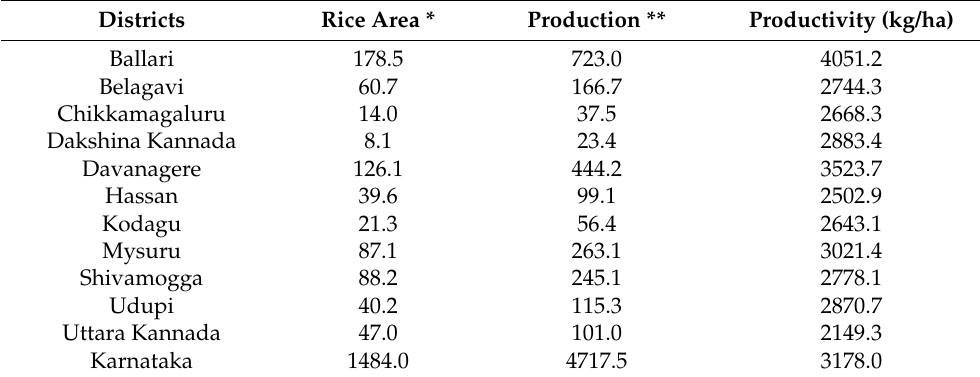
Table 1. Area, production, and productivity of rice (2020).